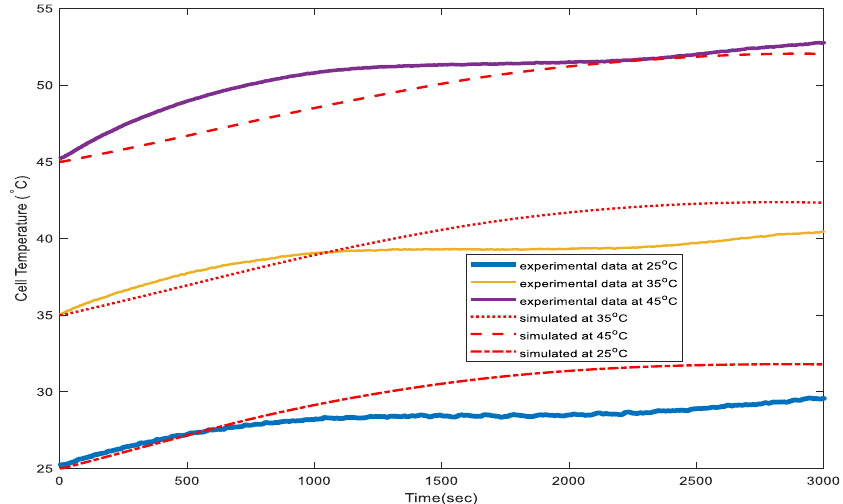
Figure 13. Cell temperature at different ambient temperature (for constant 2 A load current) for 3000 s.